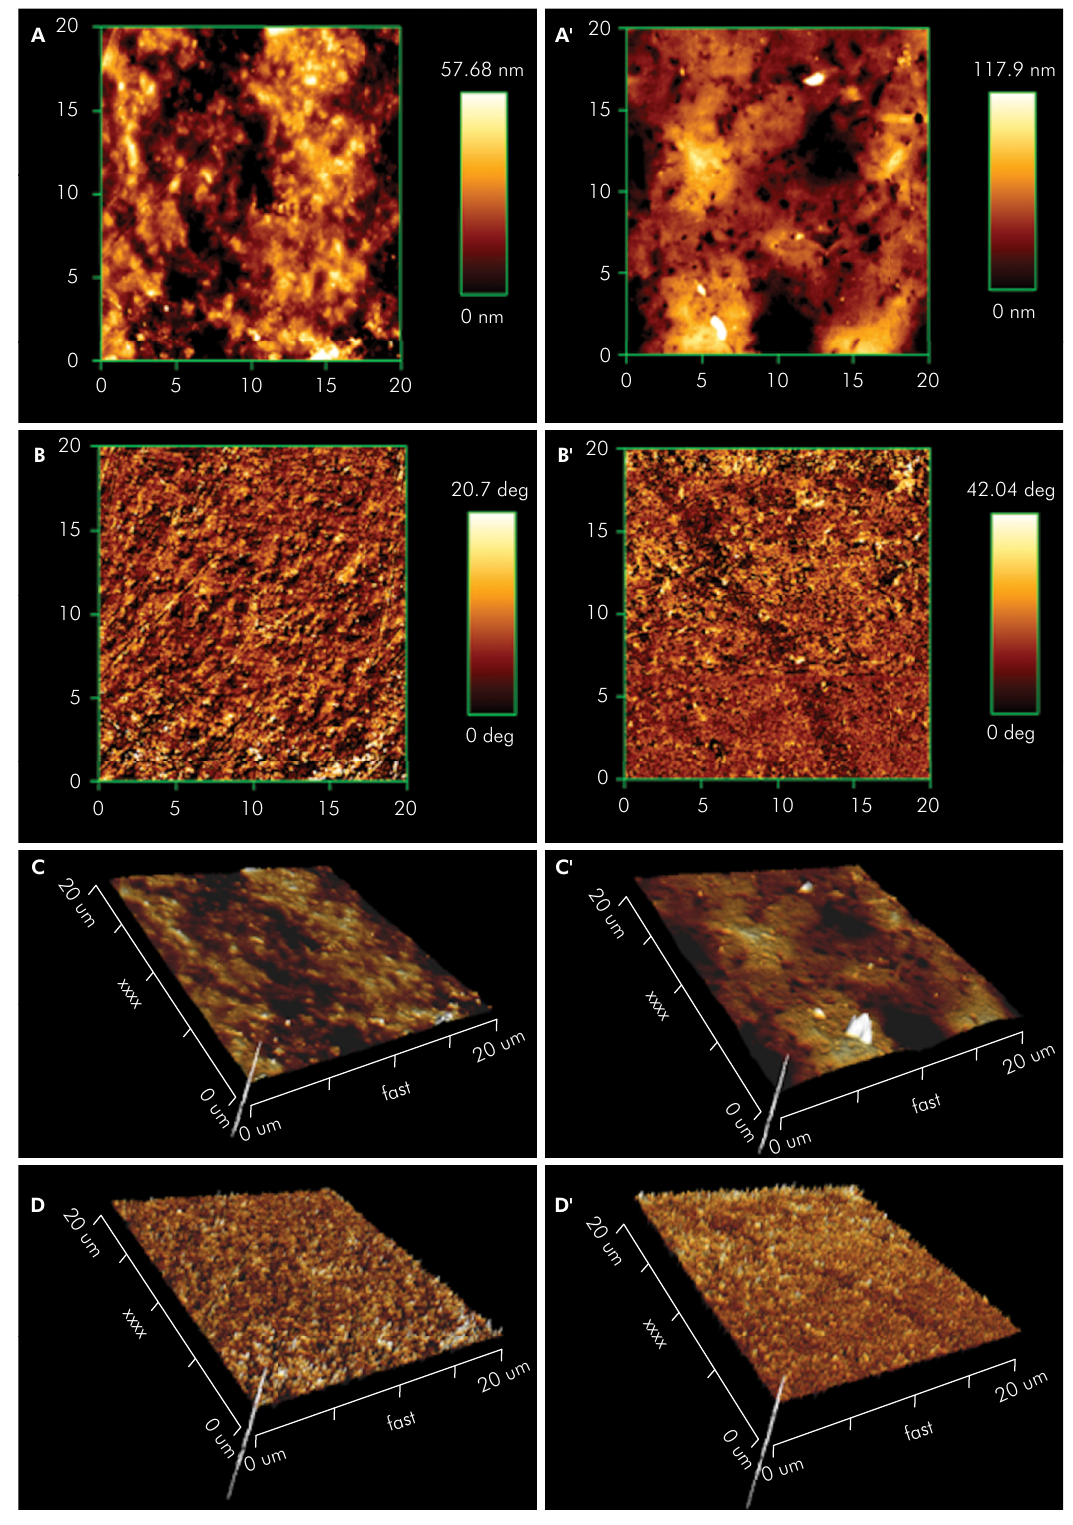
Figure 2. Photomicrographs in AFM of specimen surfaces from Group PLUS, before and after pH-cycling, respectively being: A and A’: two-dimensional images in height; B and B’: two-dimensional images of lock-in phase; C and C’: three-dimensional images in height; D and D’: three-dimensional images of lock-in